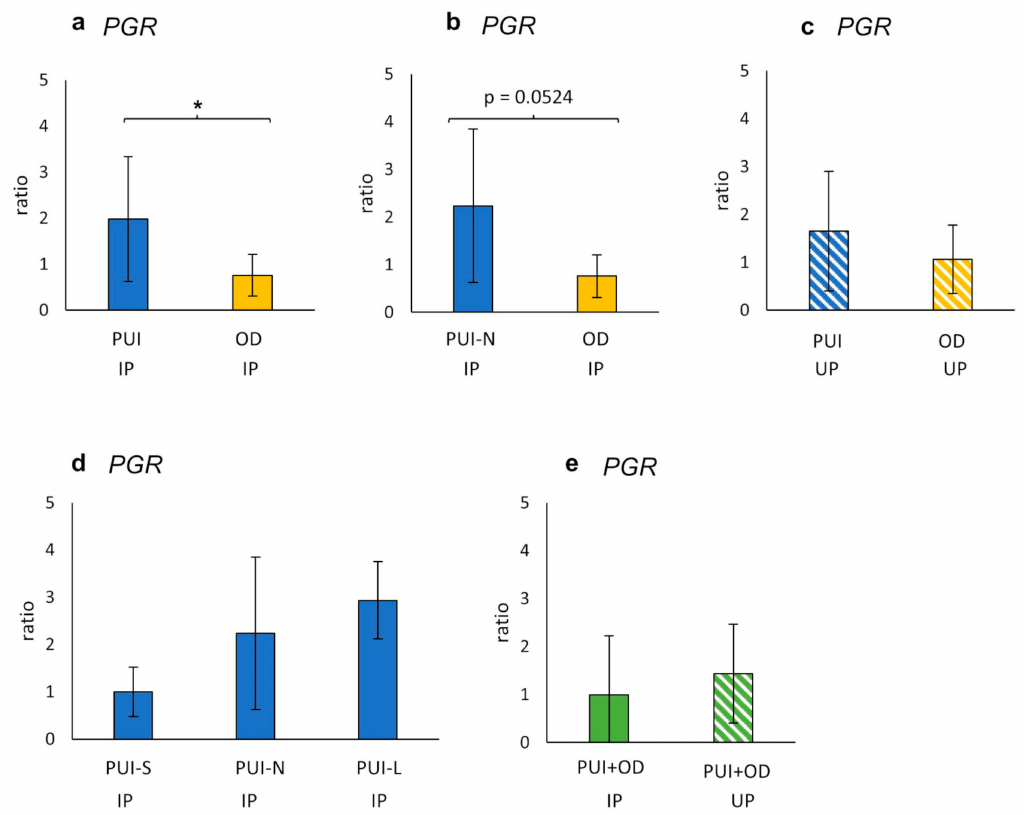
Figure 5. Interplacental (IP) ( a , b , d ) and uteroplacental (UP) ( c ) PGR mRNA-expression (ratio) com- paring ( a , c ) PUI (IP n = 11; UP n = 4) or ( b ) PUI-N (IP only, n = 4), respectively, and OD (IP n = 8; UP n = 5). ( d ) PGR mRNA expression differentiating uterine inertia subgroups according to litter size (PUI-S: n = 4; PUI-N: n = 4; PUI-L: n = 3). ( e ) PGR mRNA expression summarized for both groups (PUI + OD) for comparison of location (IP versus UP). Results are shown as mean ± SD. Bars with asterisk differ significantly (* p < 0.05); a trend ( p = 0.0524) is also